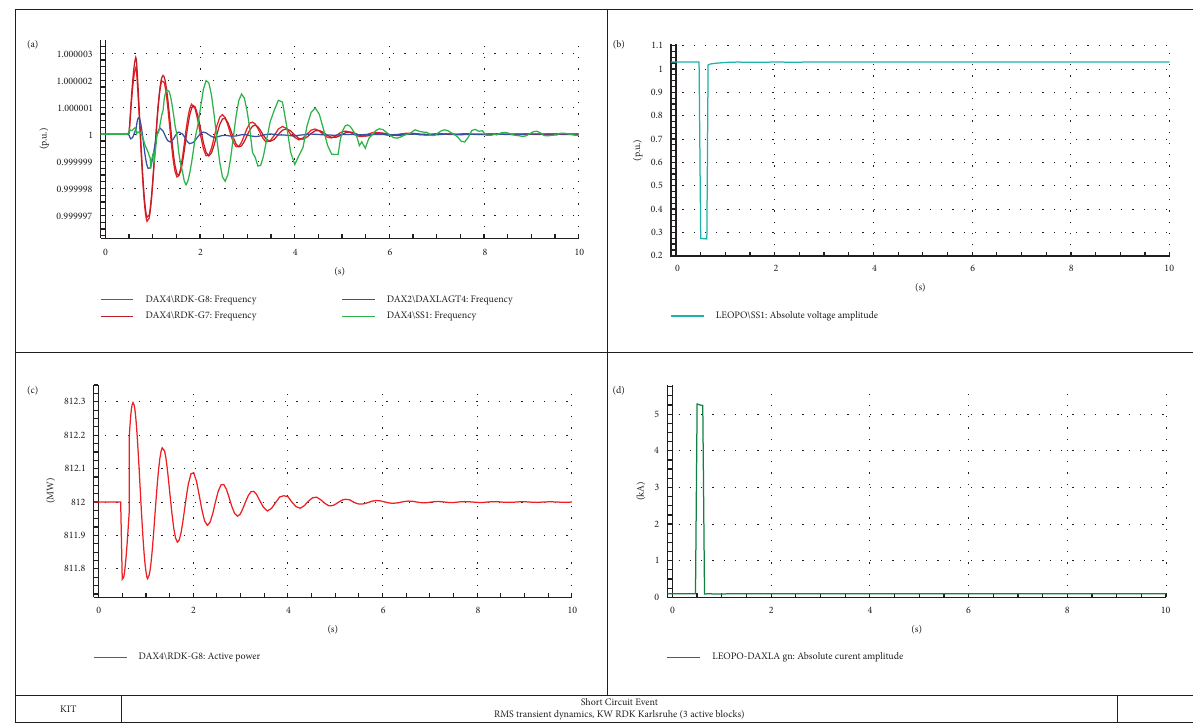
Figure 3: Frequency and power dynamics in a transmission grid display characteristic subsecond dynamics. We display the local fre- quencies at 380/220/110-kV station DAXLA with 3 powerstation-blocks (a), the real power of one block (b), as well as the absolute voltage amplitude (c), and the absolute current on the line that displayed a short circuit to trigger the event (d). Te transient dynamics is triggered via a three-phase short circuit between 0.5 and 0.65seconds on a 110kV line between Daxlanden and Leopoldshafen (connection point of the KITcampus North). Line and node parameters use realistic values for the South-West German power grid. Frequency and voltage are given in the per-unit (p.u.) system, i.e., at 1 p.u., they are at the reference value.